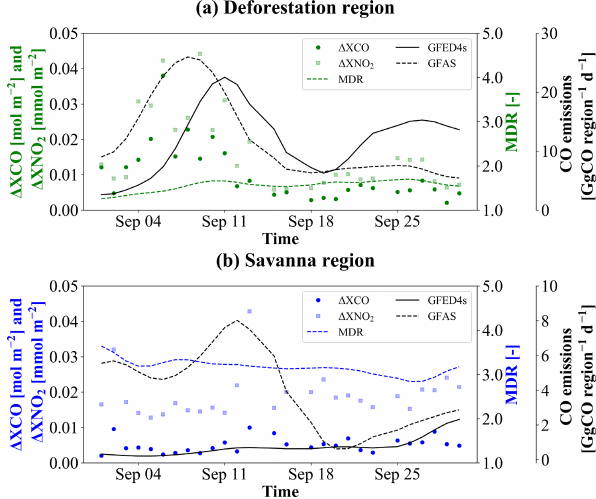
Figure 10. September 2018 daily estimates of (cid:49)X CO (molm − 2 ) and (cid:49)X NO 2 (mmolm − 2 ) from TROPOMI derived with the SBM, together with smoothed estimates of the MDR (colored dashed line), and smoothed CO emission estimates (GgCO region − 1 d − 1 ) from GFED4s (black solid line) and GFAS (black dashed line). Panel (a) shows the results for the South American deforestation region and panel (b) for the South American savanna